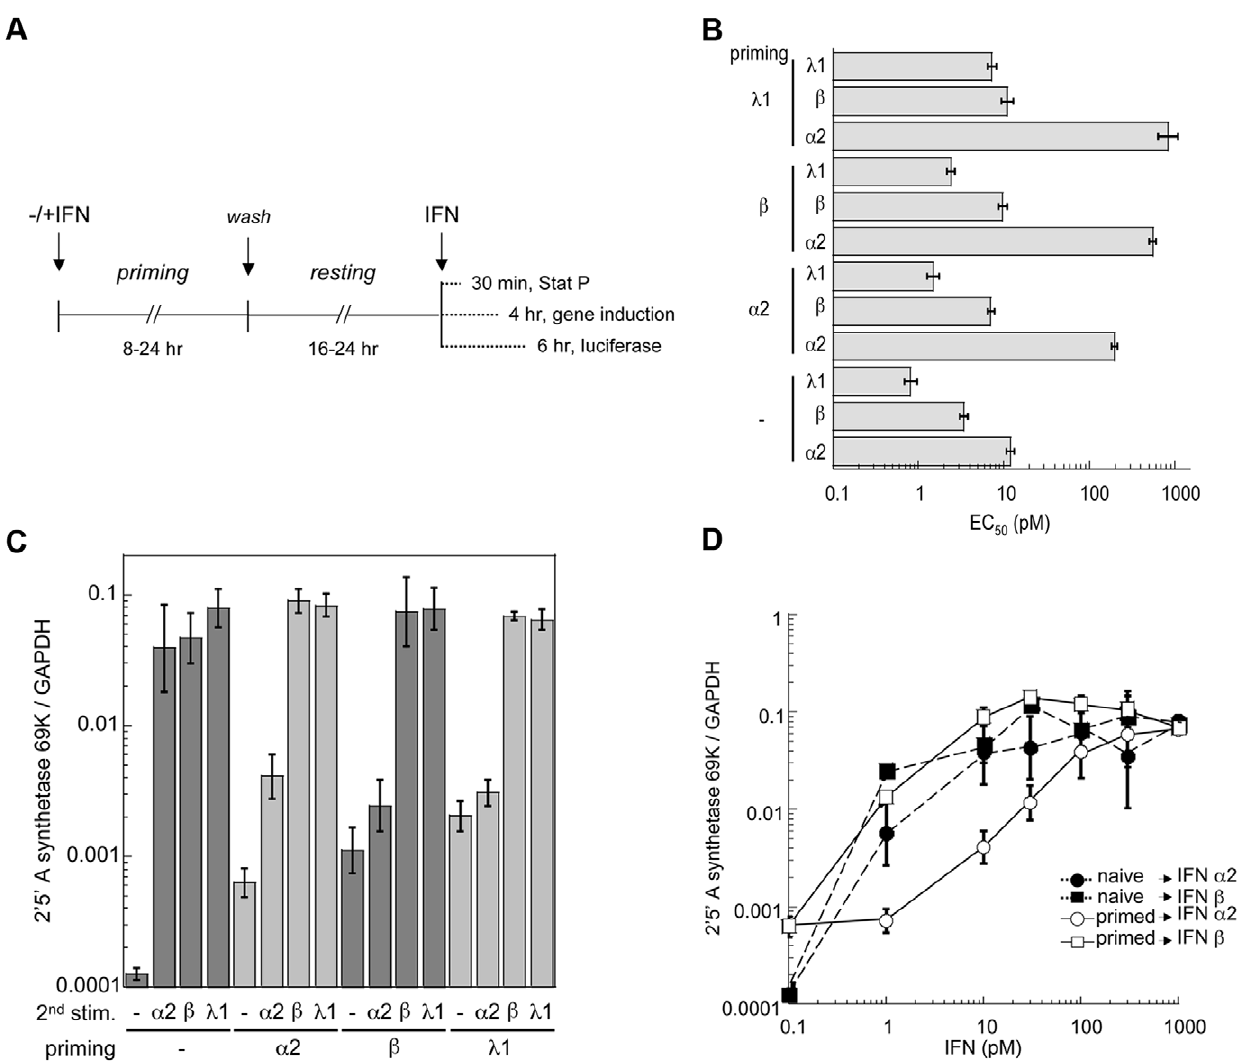
Figure 1. Differential desensitization studies in HLLR1-1.4 cells. (A) Protocol used to measure desensitization. Unless otherwise indicated, cells were primed with IFN a 2 or IFN b (500 pM) or IFN l 1 (50 pM). The priming phase varied between 8 and 24 hr and the resting phase between 16 and 24 hr. Cells were then challenged with IFN for different times depending of the read out. (B) Graphic representation of the EC 50 (pM) as determined by the luciferase activity induced by IFN a 2, IFN b or IFN l 1 in naı¨ve or primed cells. EC 50 were calculated from the non-linear regression fits of the luciferase activity induced by IFN in a concentration range covering 2.4 log. Priming and resting times lasted 24 hr each. Bars represent the 95% confidence limits. (C) Level of OAS-69K mRNA induced by IFN a 2 (10 pM), IFN b (10 pM) or IFN l 1 (50 pM) in naı¨ve and primed cells as determined by RT-qPCR. Data are expressed as ratios to GAPDH levels. Priming and resting times lasted 24 hr each. Bars represent the 95% confidence limits (Student’s t-test). (D) Dose response induction profile of OAS-69K mRNA in naı¨ve (closed symbols) and IFN a 2 primed cells (open symbols) stimulated for 4 hr with different doses of IFN a 2 (circles) or IFN b (squares) as determined by RT-qPCR. Priming and resting times lasted 24 hr each. Data are expressed as ratios to GAPDH levels. Bars represent the 95% confidence limits (Student’s